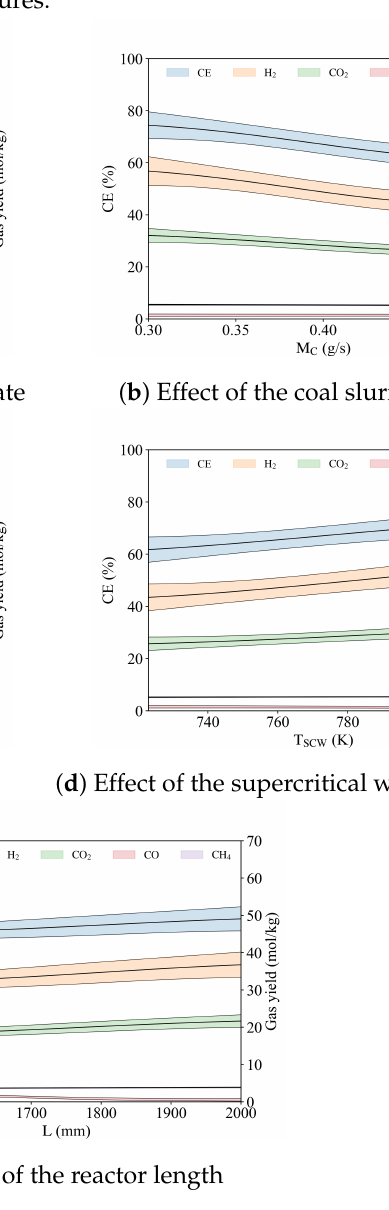
Figure 7. Single-parameter analysis on the CE and the gas yield of the SCWFB